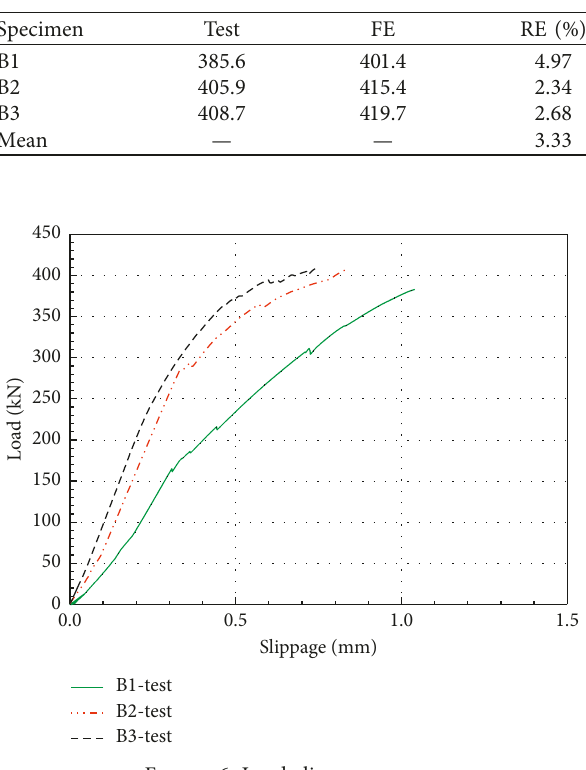
Figure 6: Load-slippage